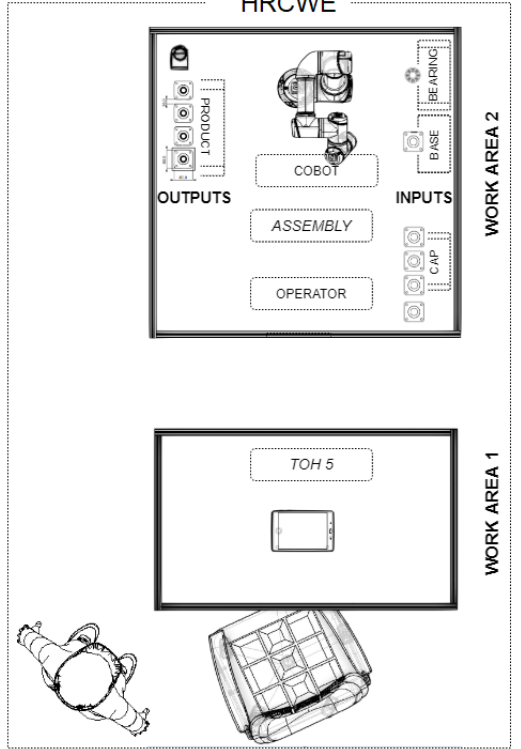
Figure 3. The human-robot collaboration workspace’s experience, HRCWE.